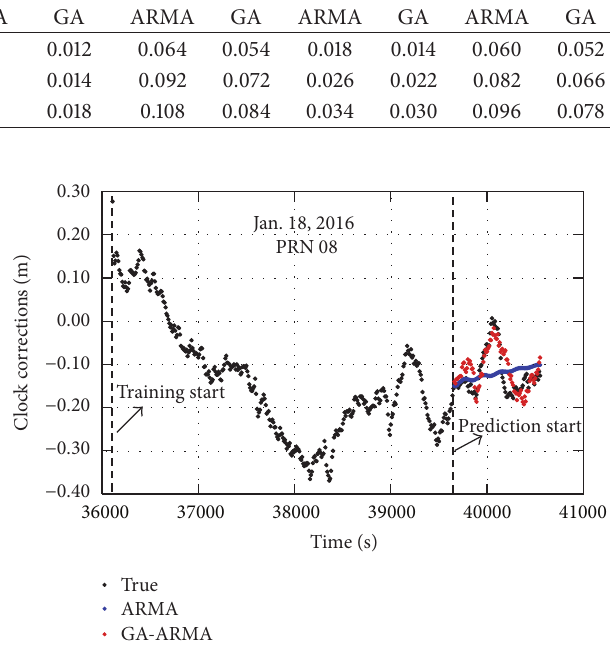
Figure 4: RTS clock correction and prediction result (PRN 08, January 18,